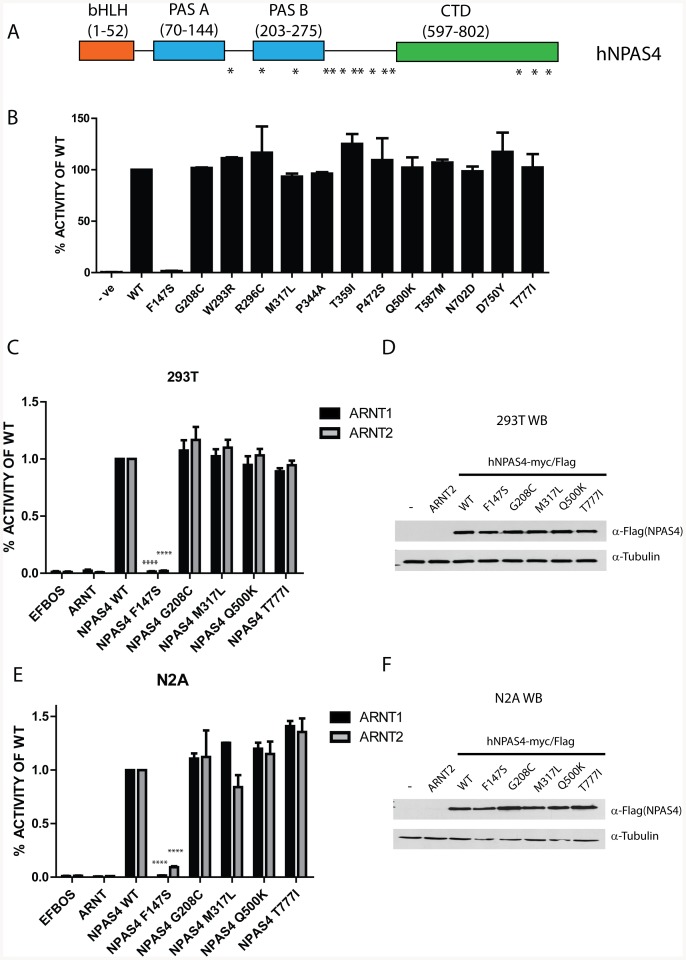
Functional Analysis of human NPAS4 Variants.A, Schematic of domains within NPAS4 showing positions of analysed non-synonymous variants. B, A screen of NPAS4-mycFlag variants using NPAS4/ARNT2 activation of a reporter gene (6xCME-Luc) in HEK293T cells transfected with NPAS4-MycFlag and ARNT2 expression vectors. Values represent average percentage activity of WT NPAS4-mycFlag ±SD of two independent experiments. C and E, NPAS4-MycFlag variant activation of the 6xCME-Luc reporter gene upon co-expression of ARNT1 or ARNT2 as the dimerisation partner in HEK293T cells (C) or Neuro2A cells (E). Data are mean percentage activity of WT NPAS4-mycFlag ±SEM of at least 3 independent experiments. Statistical significance was calculated using an ANOVA compared to WT NPAS4-mycFlag. Cell lysates from reporter assays in C and E were separated by SDS-PAGE and NPAS4-mycFlag protein detected by immunoblotting using α-Flag antibodies, with α-tubulin was used as a loading control. Representative western blots of NPAS4-mycFlag variants are shown for HEK293T cells (D) and Neuro2A cells (F). ****p<0.0001.